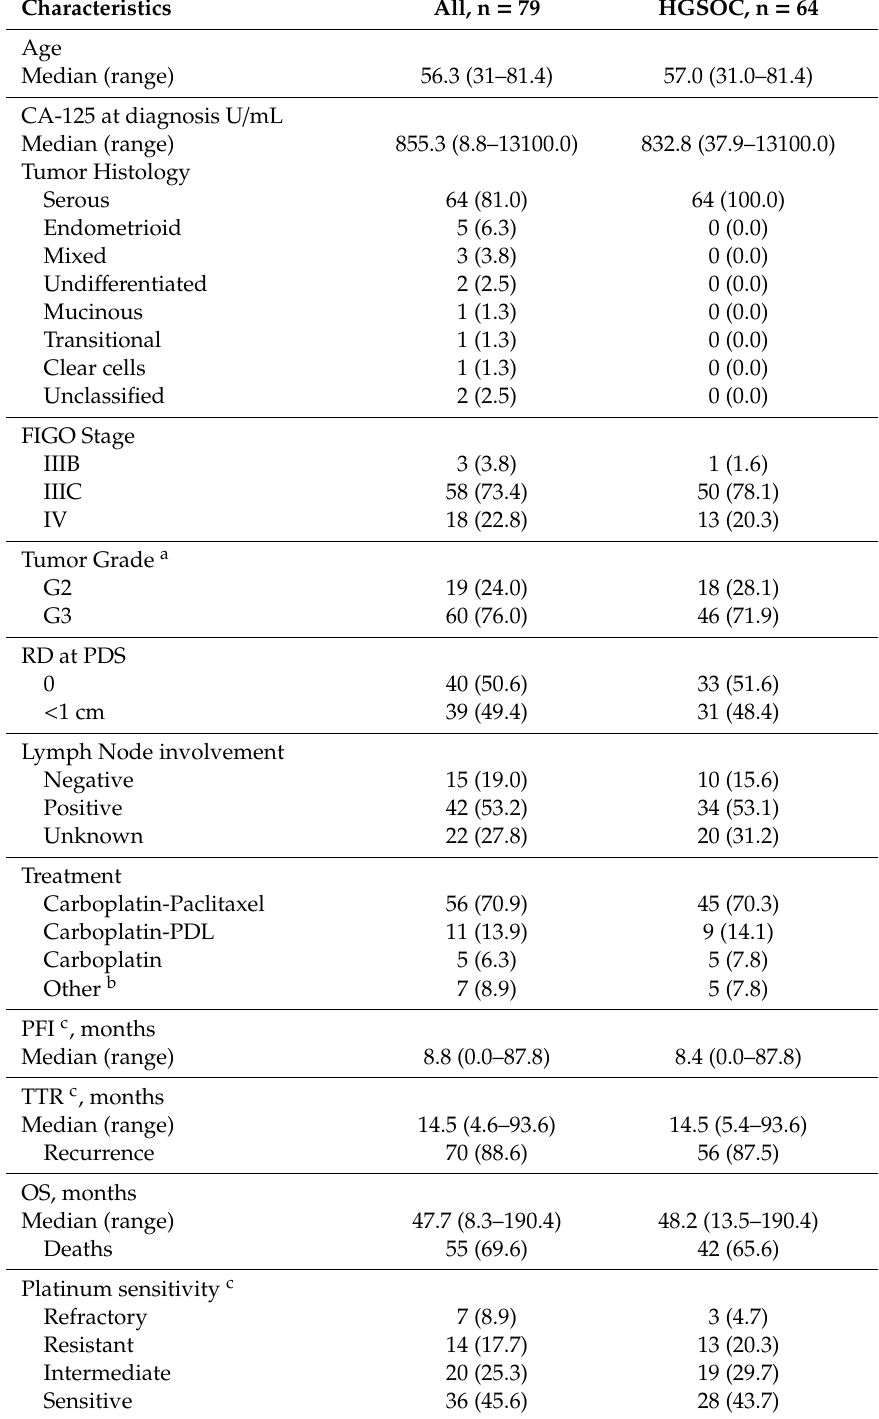
Table 1. Clinico-pathologic characteristics of patients with advanced ovarian cancer, including HGSOC.